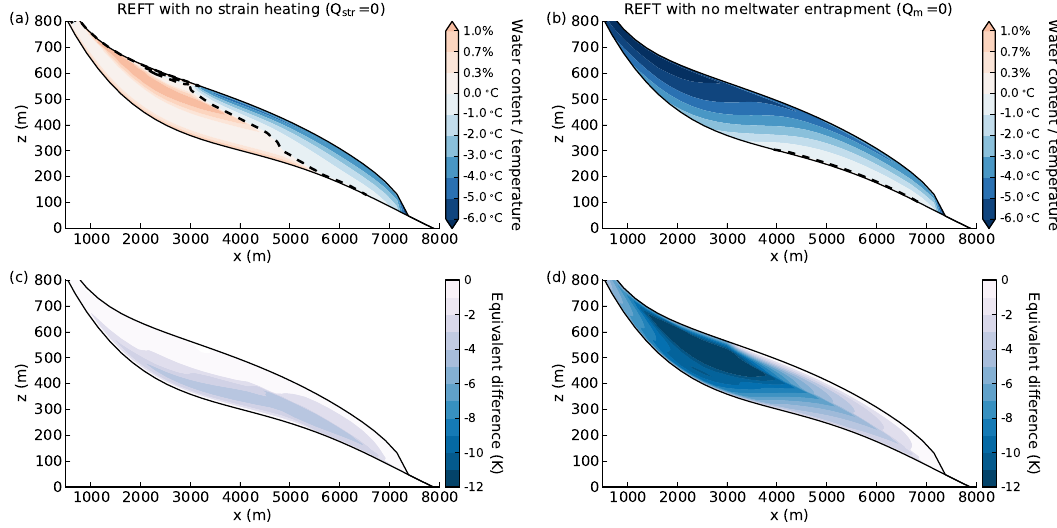
Fig. 2. Distributions of enthalpy and equivalent temperature difference ( ∆ K 0 ) for REFT with and without strain heating Q str (a,c) and meltwater entrapment Q m (b,d). Model runs use flow-law coefficient A as in Eq. (12). The dashed lines in (a,b) denote the cold-temperate transition. Darker areas in (c,d) indicate the largest differences in ice enthalpy relative to the REFT reference model. Enthalpy difference in (c,d) in equivalent temperature according to (Eq. 21).